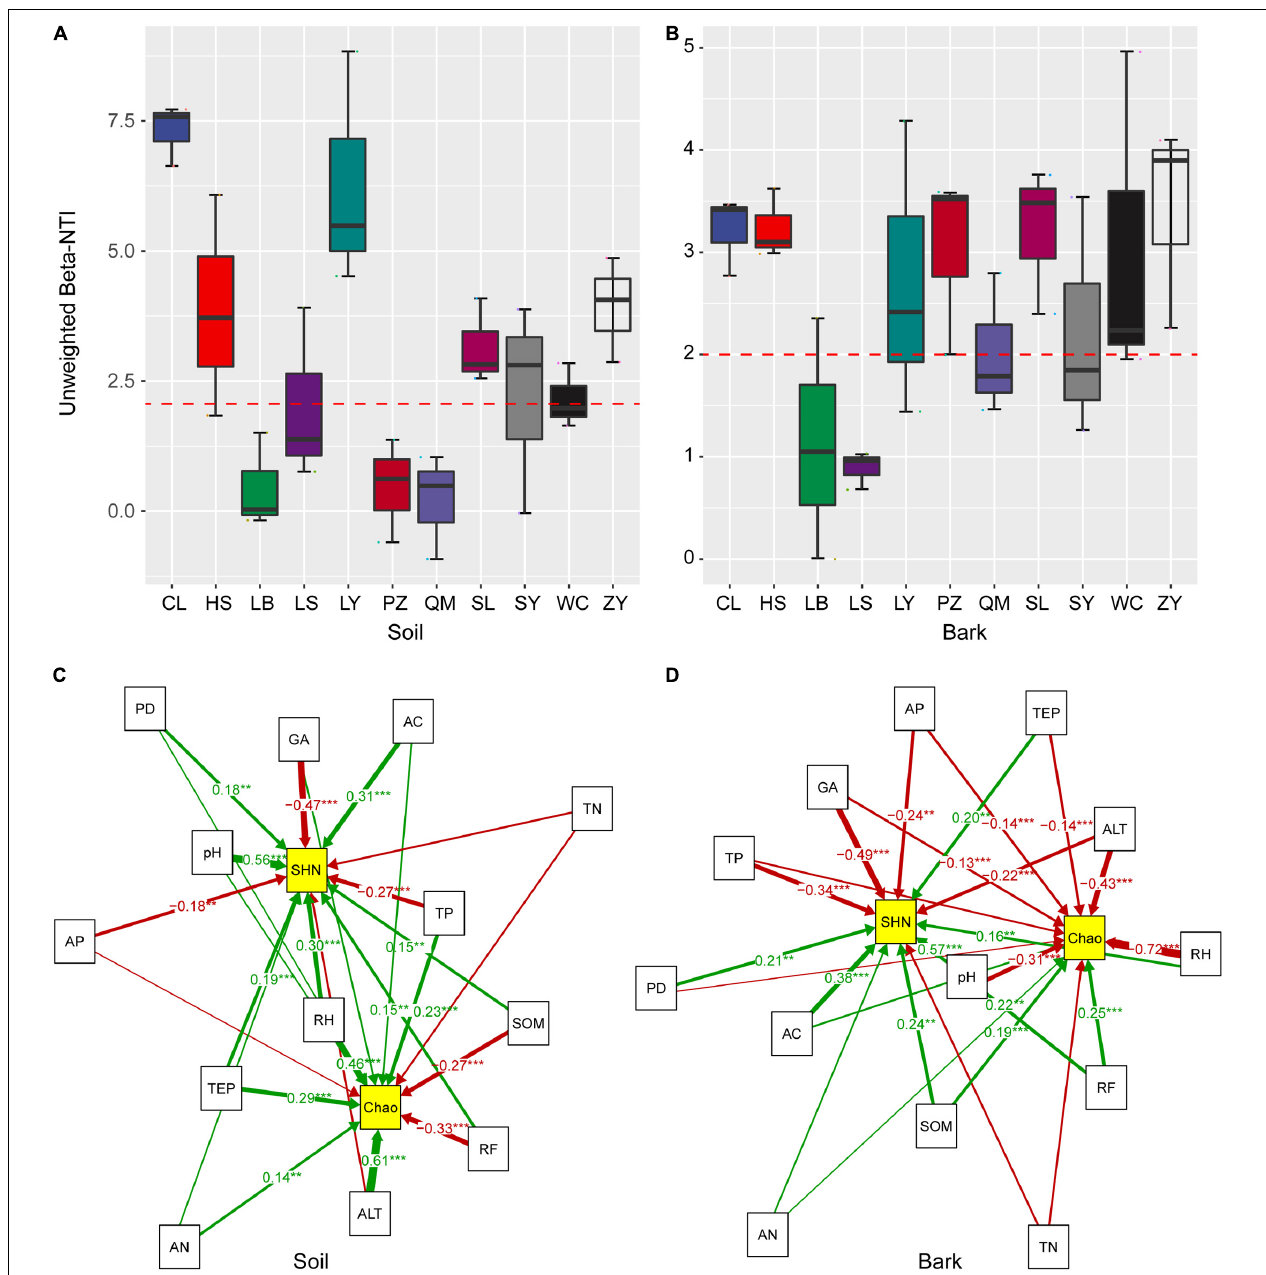
FIGURE 2 | Null model and structural equation model analysis reveals the bacterial community of assembly process of E. ulmoides . β -NTI values of bark (A) and rhizosphere soil (B) bacterial communities were distributed in 11 producing areas (C) , Fitting relationships between active compounds, soil physicochemical factors, and climatic factors, and diversity index of soil bacterial community. (D) Fitting relationships between active compounds, soil physicochemical factors, and climatic factors, and diversity index of bark bacterial community. Active compounds included geniposidic acid (GA), aucubin (AC), and pinoresinol diglucosid (PD). Soil physicochemical factors included available phosphorus (AP), soil organic matter (SOM), pH, total phosphorus (TP), available nitrogen (AN), and total nitrogen (TN). Climatic factors included Rainfall (RF), relative humidity (RH), altitude (ALT), and temperature (TEP). Diversity index includes Shannon diversity index (SHN), Chao diversity index (Chao). Solid lines and arrows show significant and non-significant relationships between different variables (variables with normalized path coefficients > 0.1). Significance levels were ** p < 0.01, *** p <